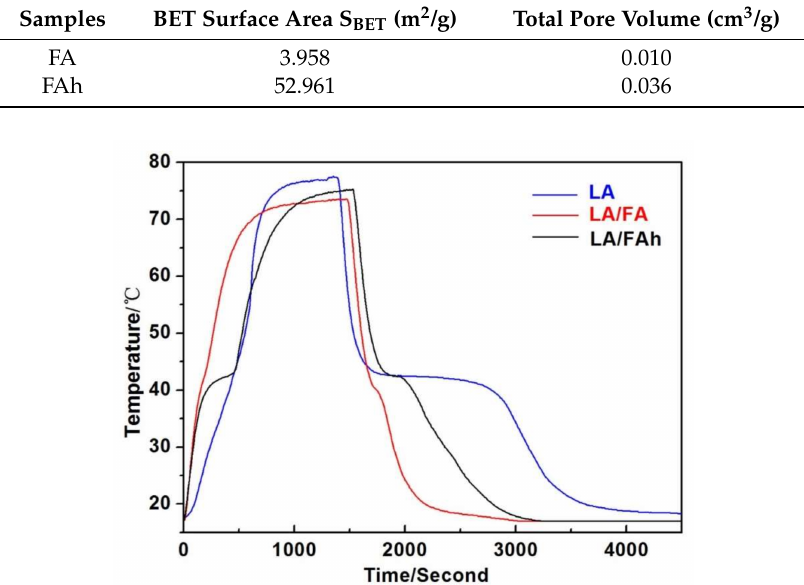
Figure 4. Melting and freezing curves of LA and corresponding